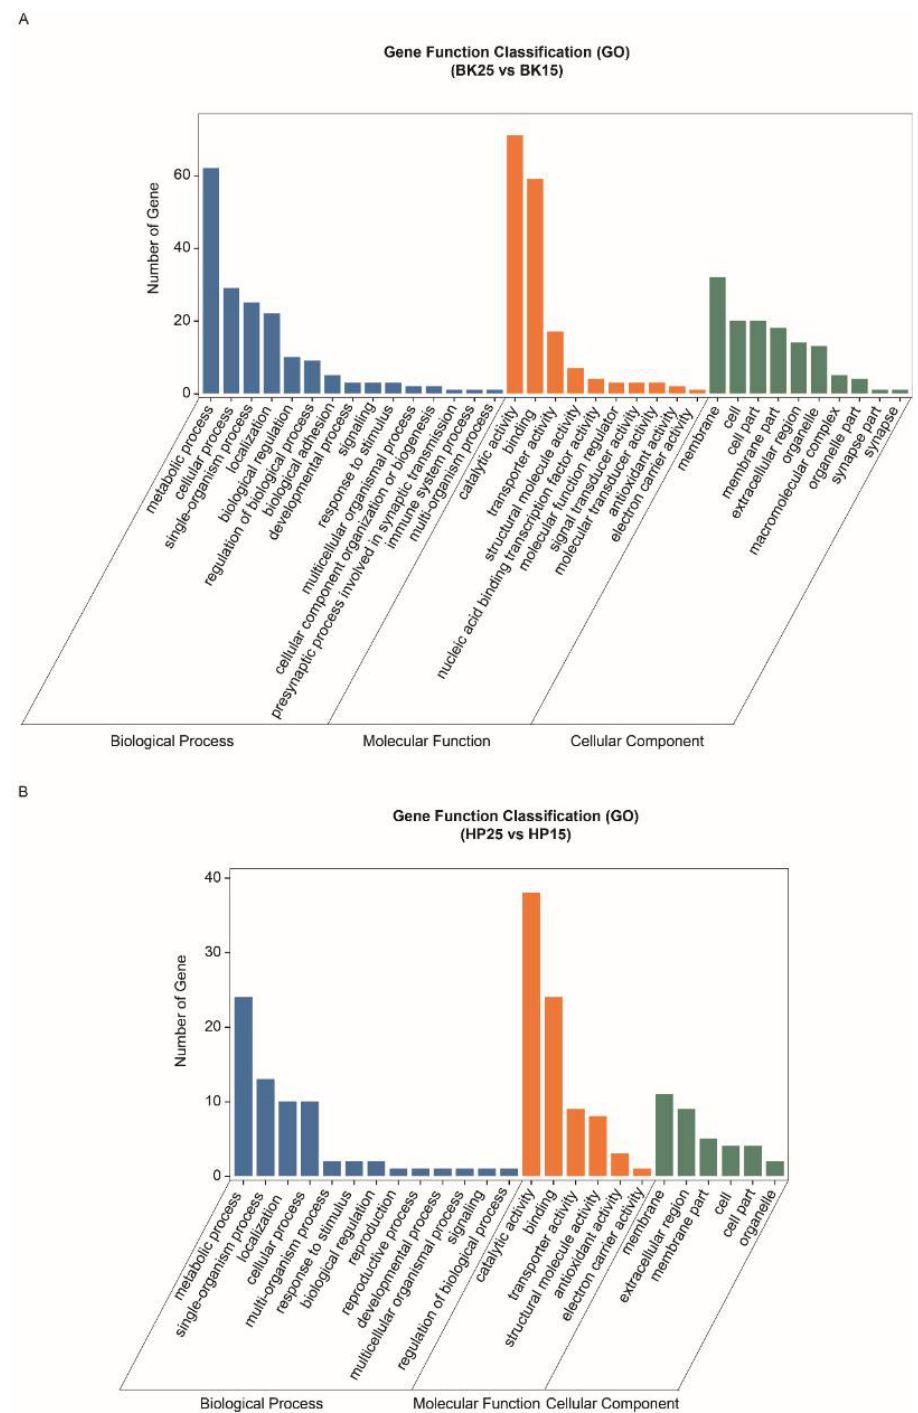
Figure 3. Gene ontology annotation of differentially expressed candidate target (DECT) genes. ( A ) Gene ontology annotation of DECT genes in the BK phase. ( B ) Gene ontology annotation of DECT genes in the HP phase.